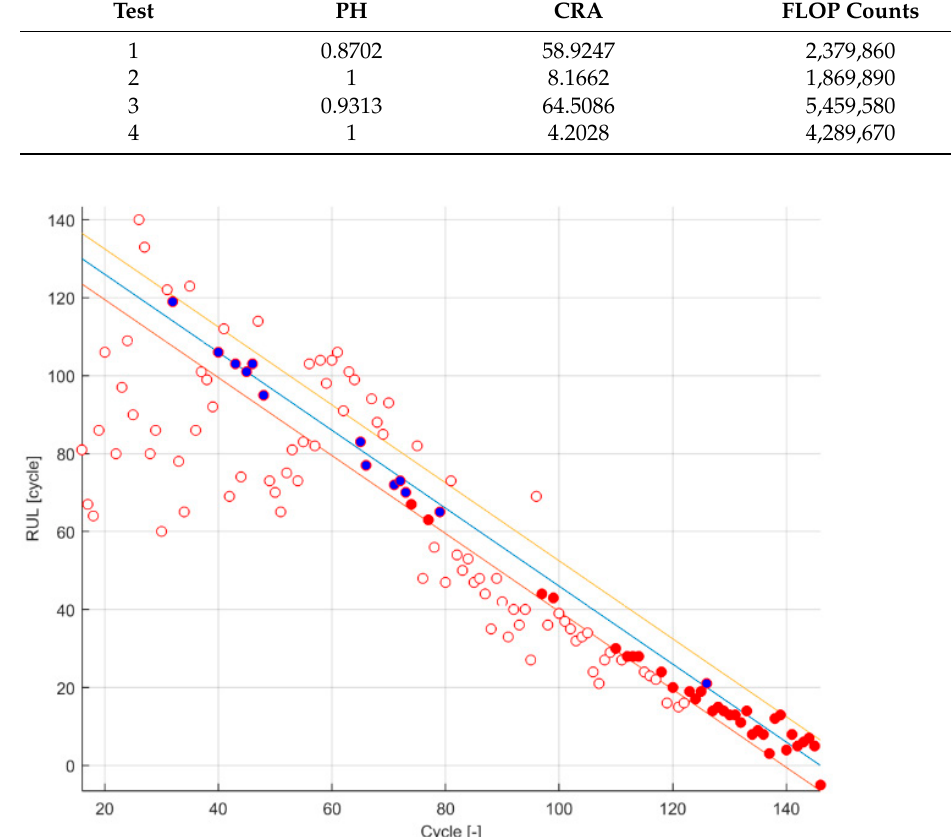
Figure 5. Results from test nº 1 (“B0007” linearly modelled).